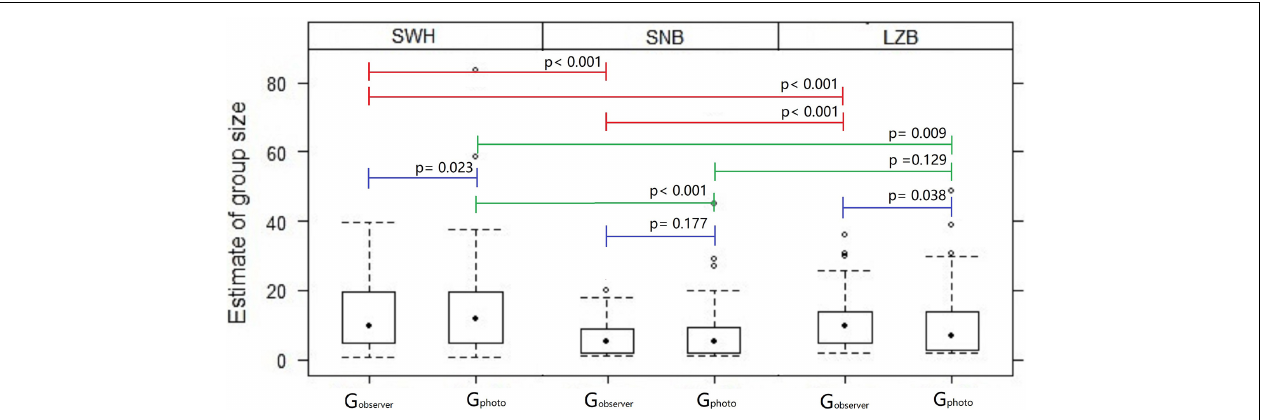
FIGURE 5 | Boxplot of humpback dolphin group size obtained from observer-based counts ( G observer ) and photo-identification estimates ( G photo ) in the SWH, SNB, and LZB. The median (black dots), lower (25%) and upper (75%) quartiles, and outlier values (black circles) are illustrated. P -values were indicated for the paired comparisons of group size between methods and geographic comparisons of group size between regions, with a significance level of < 0.05.